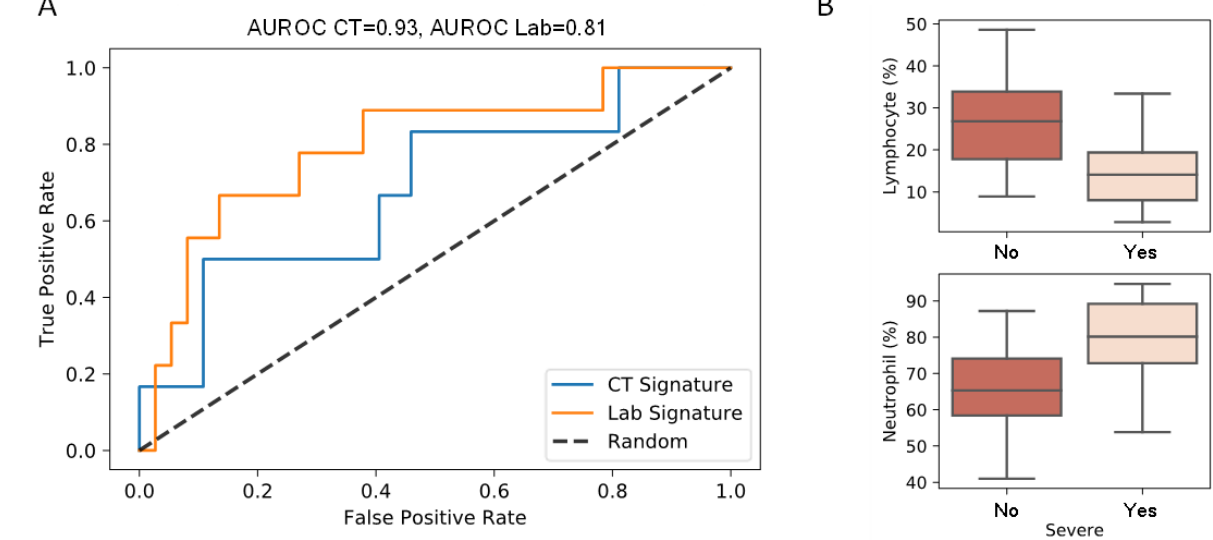
Figure 5. COVID-19 severity forecasted using the prediction model. (A) Forecasting severity using patient’s nonsevere records noted upon admission. (B) Laboratory tests showing a significant relation to the severity forecast.